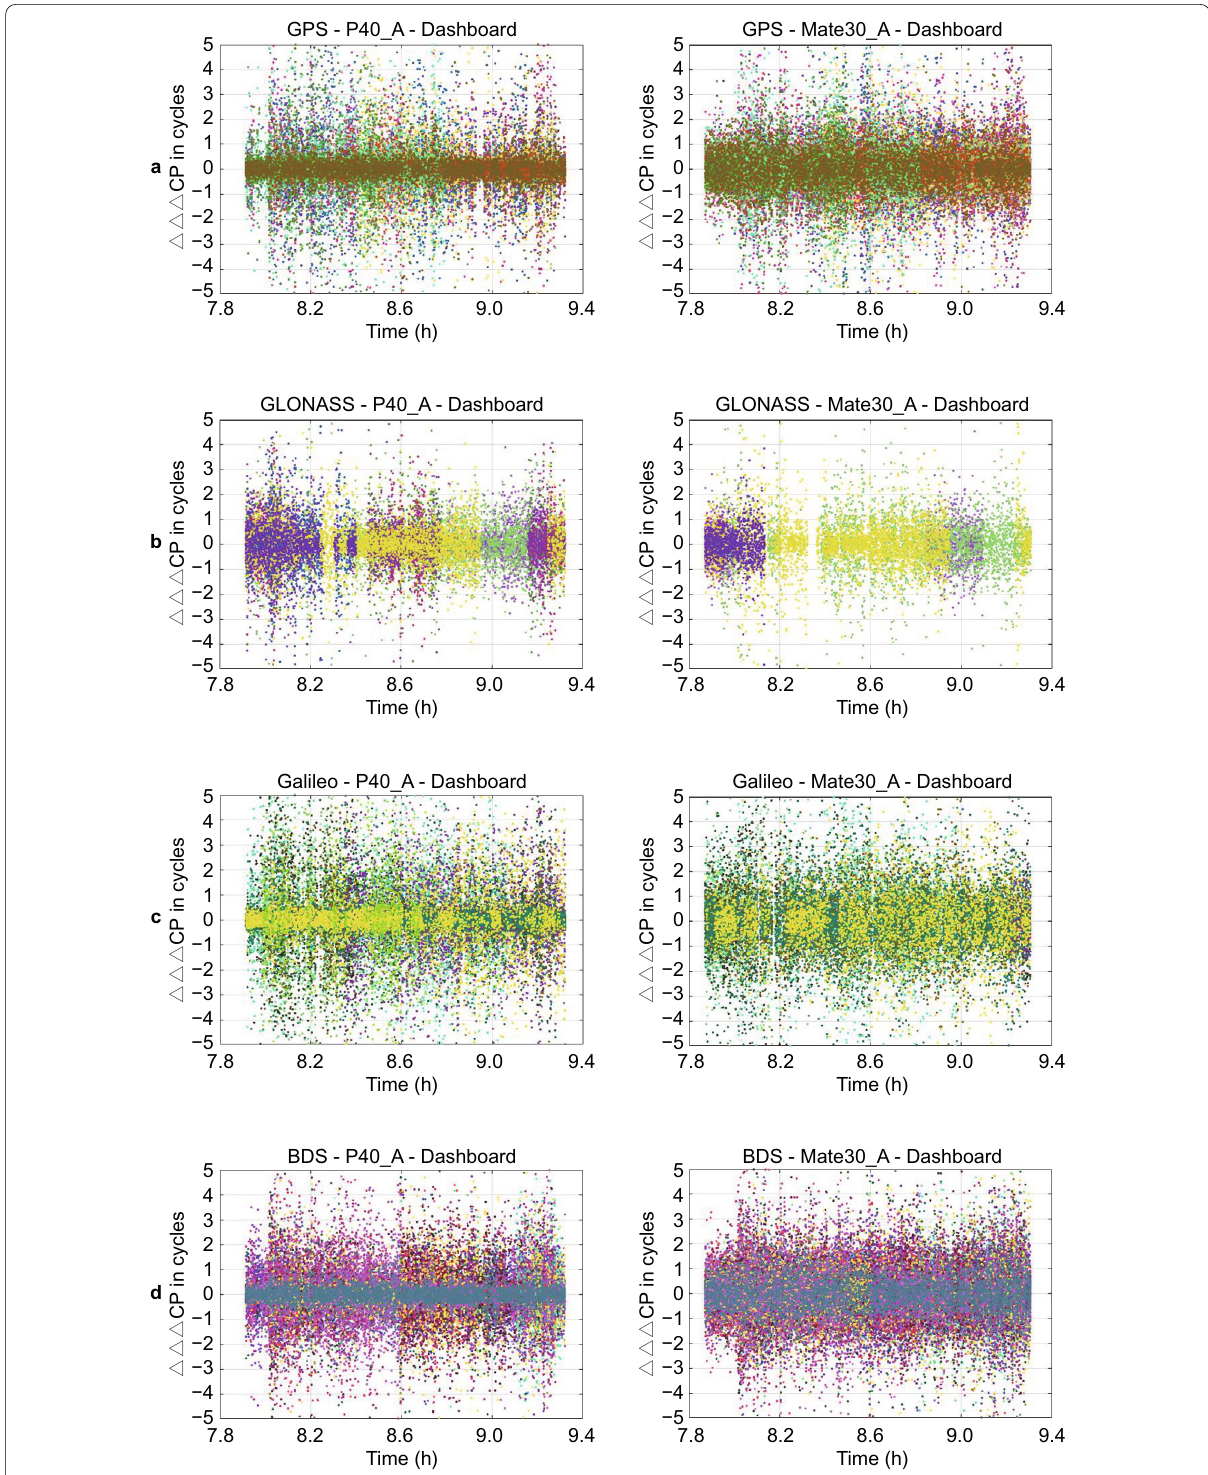
Fig. 8 Time series of triple differenced carrier phase observations (denoted by ΔΔΔCP) of a GPS L1, b GLONASS L1, c Galileo E1, and d BDS B1I for the P40_A and Mate30_A experimental smartphones in the dashboard